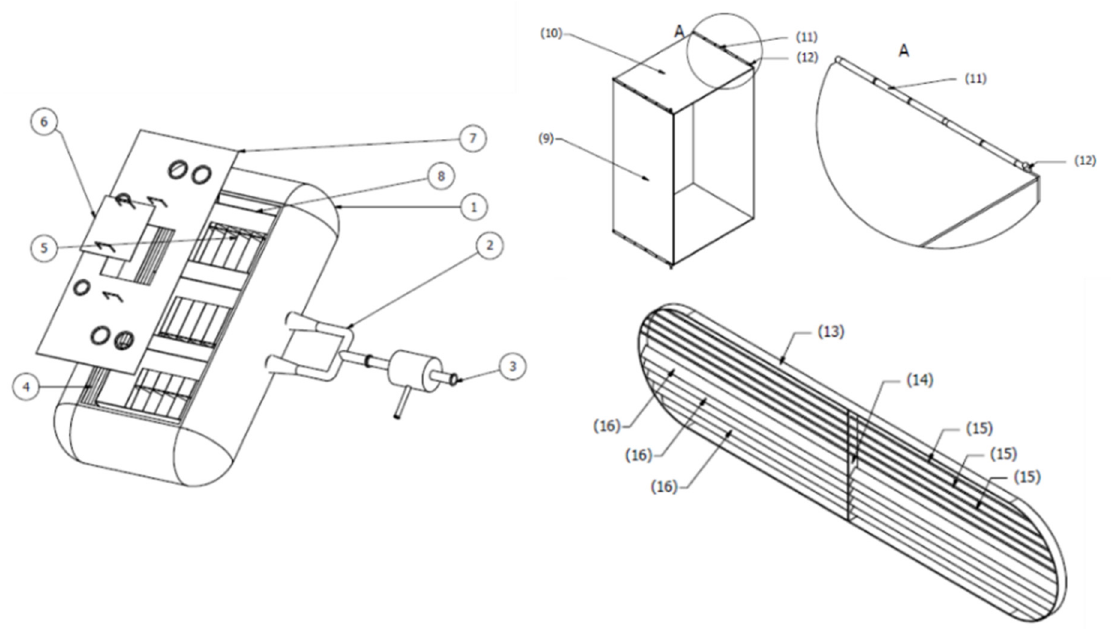
Figure A1. Diagram of the fixed-bed bioreactor and some of its accessories. Source: References [18,19]. [Reprinted from: Nova Science Publishers, Solid-State Cultivation of Grifola frondosa and Ganoderma lucidum: Technology, Research and Possibilities for Waste Utilization in Tropical Weathers, pp. 284, copyright (2020) Montoya, S.; Sánchez, Ó.J.; Arias, D.F. The statement, with permission from Nova Science Publishers, Inc.]